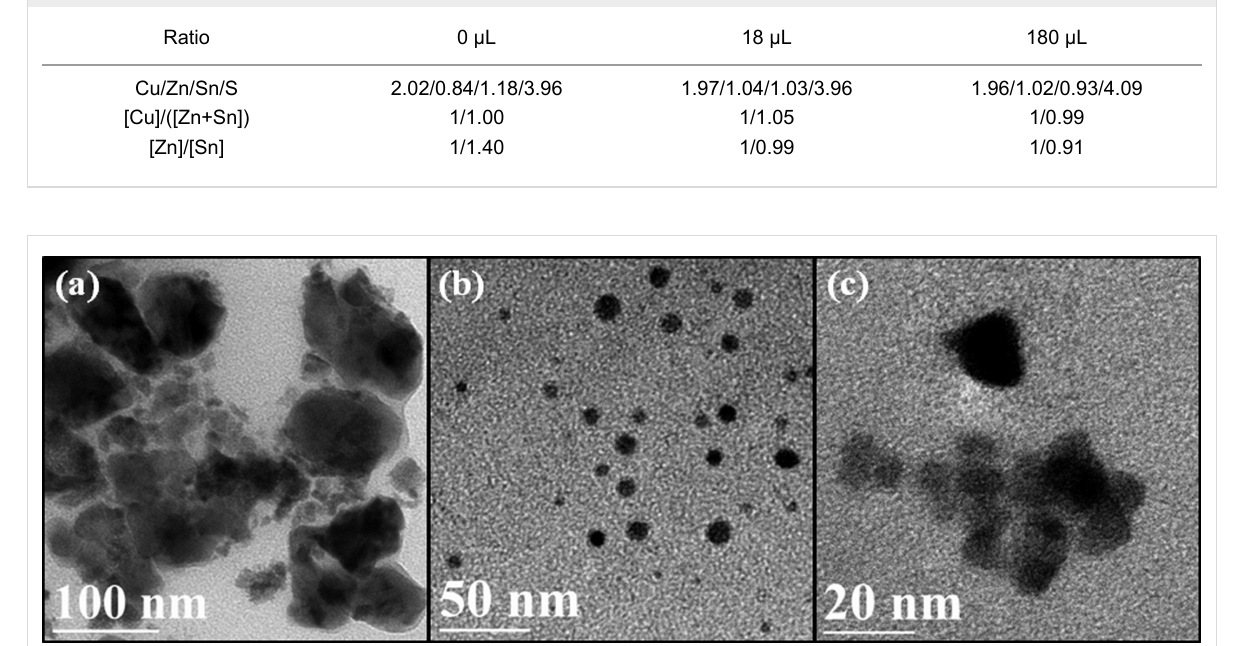
Table 1: Quantitative elemental analysis of CZTS nanocrystals synthesized with different TGA content in the precursor solution of the hydrothermal reaction.